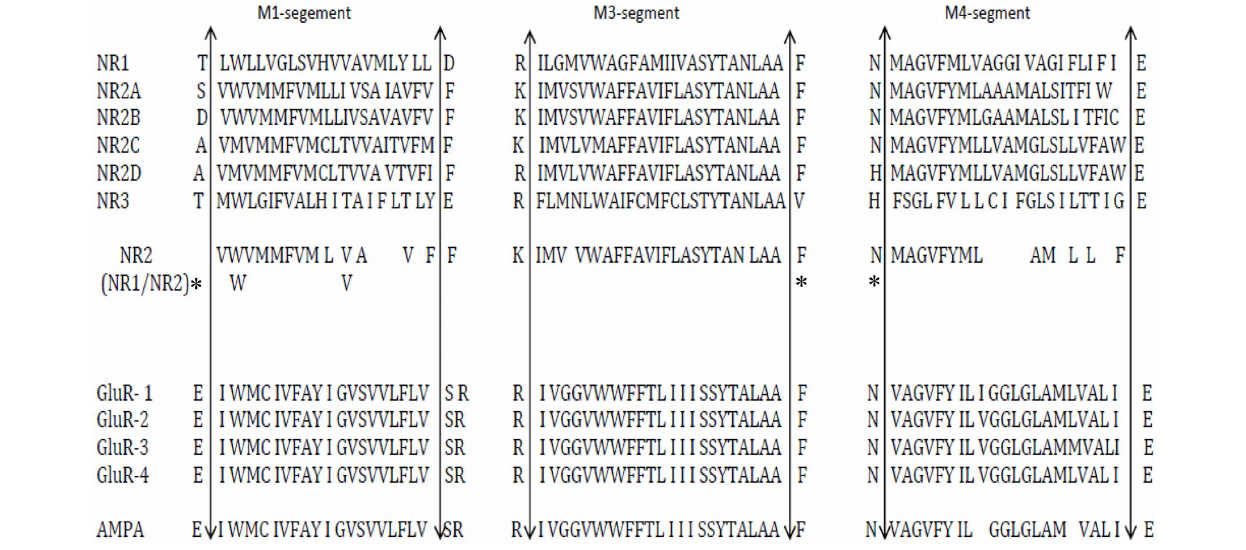
Frontiers in Molecular